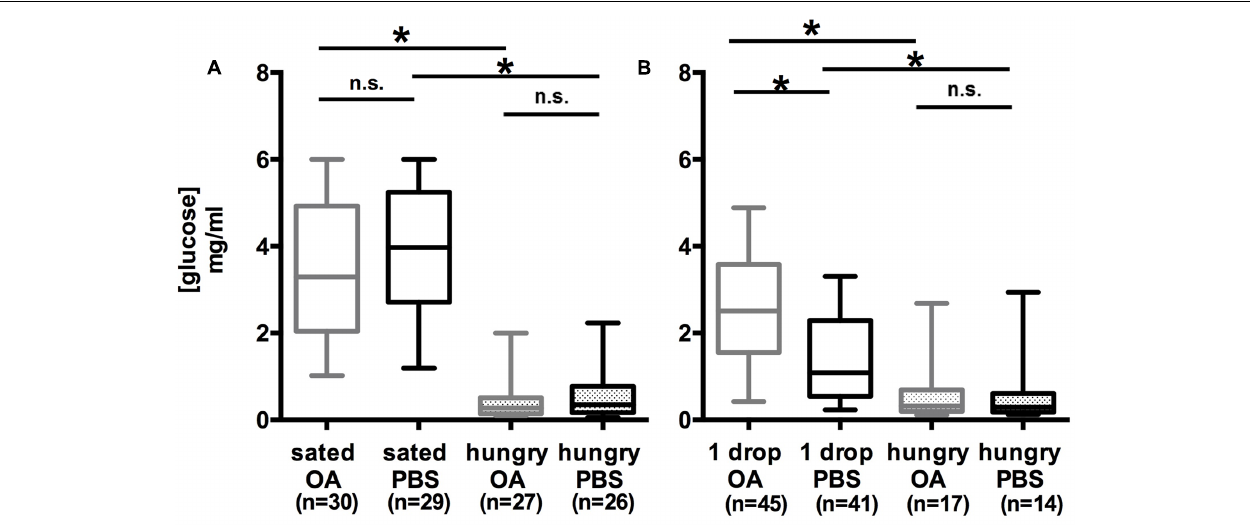
FIGURE 2 | High hemolymph glucose concentration in honeybees following octopamine treatment depends on the feeding state. (A) The hemolymph glucose level of bees fed with 30% (w/v) sucrose solution (0.88 M) to satiation (sated PBS) was higher than that of hungry bees that remained unfed (hungry PBS). Octopamine had no effect on the hemolymph glucose concentration of sated (sated PBS vs. sated OA) and hungry (hungry PBS vs. hungry OA) bees. (B) The glucose level in the hemolymph of bees fed with 4 µ l 30% (w/v) sucrose solution (0.88 M) (1 drop PBS) was higher than that of hungry bees (hungry PBS). Octopamine increased the hemolymph glucose concentration of bees fed with 4 µ l 30% (w/v) sucrose solution (0.88 M) (1 drop PBS vs. 1 drop OA). ∗ p < 0.05. Number of bees appears in brackets.